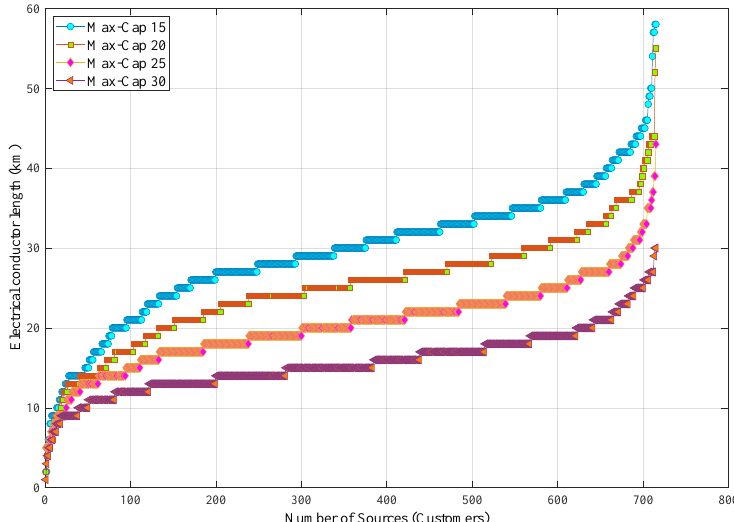
Figure 5. Length of the conductor related to the distance from the source to the load.